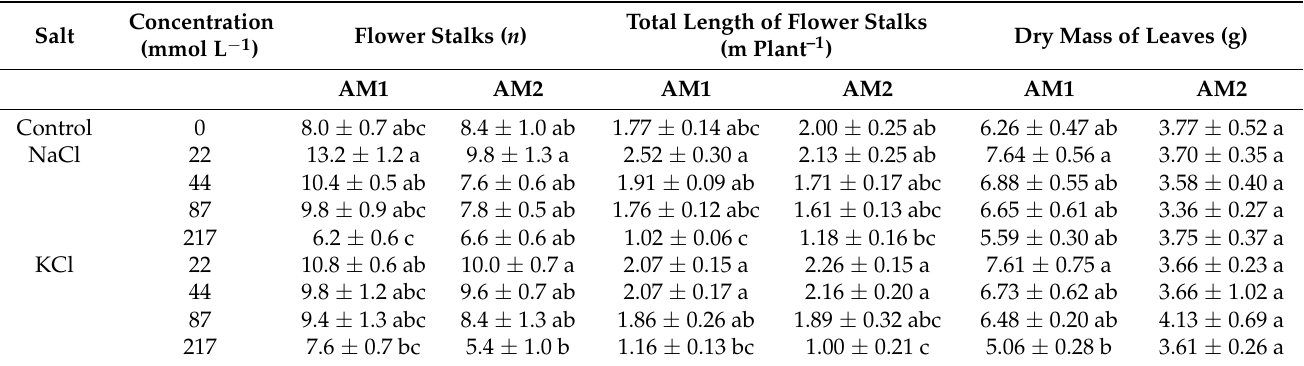
Table 2. Effect of salinity treatment on morphological parameters of Armeria maritima accessions AM1 and AM2 cultivated for 8 weeks in soil.